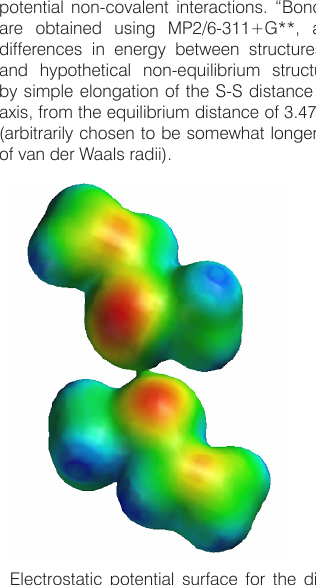
Figure 7. Electrostatic potential surface for the dimer shown in Fig. 6 (methyl groups included; isocontour